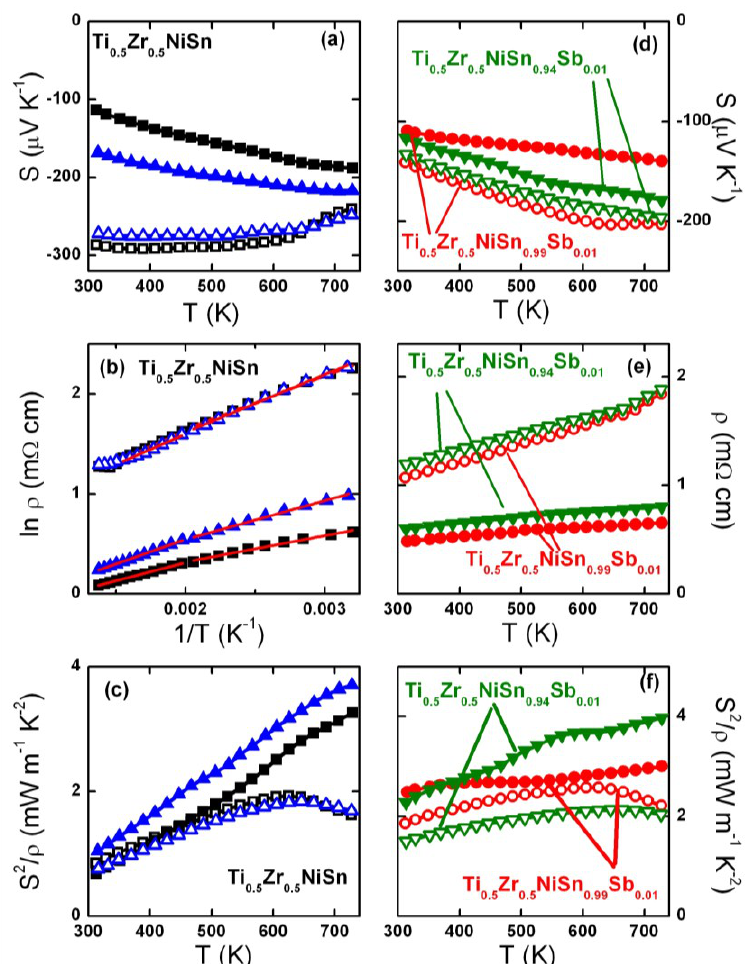
Figure 3. Temperature dependence of Seebeck coefficient (S), resistivity (ρ) and power factor (S 2 /ρ) for the Ti 0.5 Zr 0.5 NiSn ( a – c ) and the Ti 0.5 Zr 0.5 NiSn 1/0.95−y Sb y ( d – f ) samples. Open symbols represent the pre-SPS samples and the filled symbols are for the post-SPS samples. Red lines in ( b ) correspond to Arrhenius fits to the data, as detailed in Table